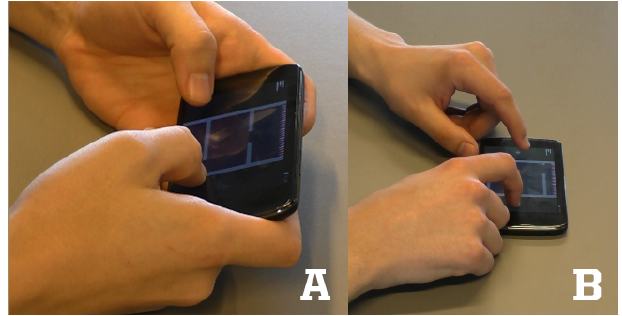
Figure 3. Different grip types while playing Drop in the lab: Firm grip input with two thumbs (A) and table rested input with index finger